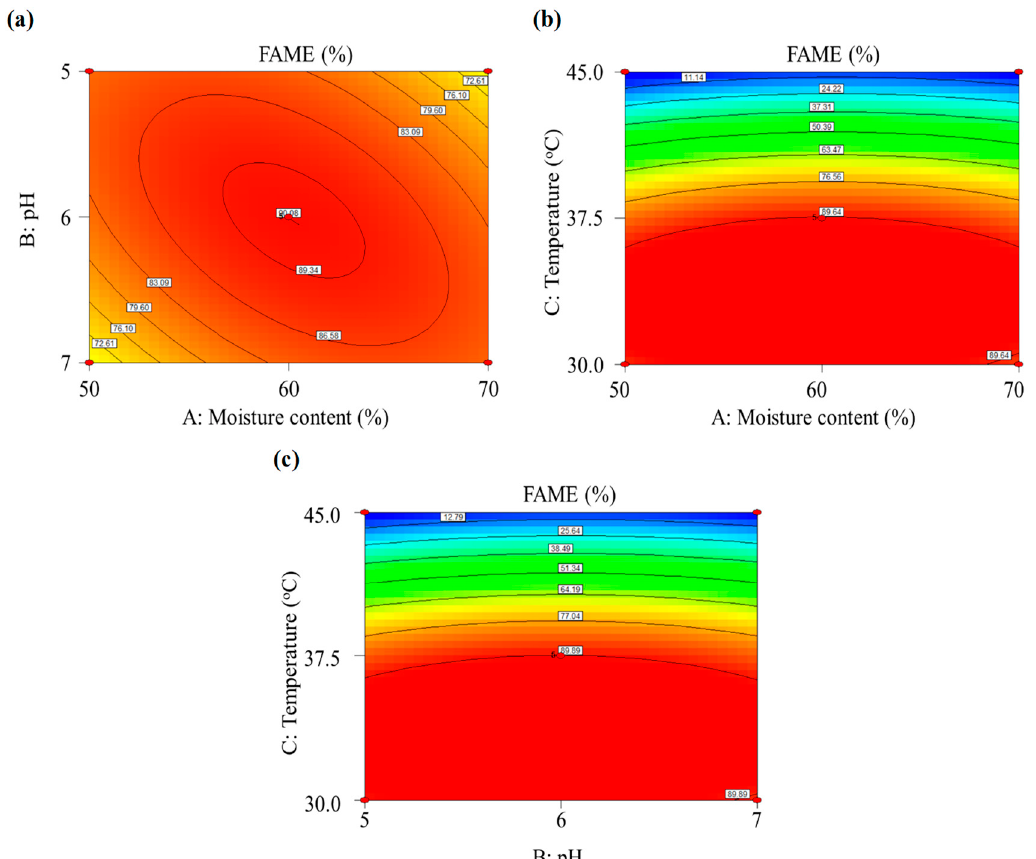
Figure 2. Two-dimensional contour plots showing the effect of ( A ): moisture content (%), ( B ): pH, ( C ): temperature (°C) on fatty acid methyl esters (FAME; %) synthesized by esterification. One variable kept constant at its center point and other two variables varied within the experimental range. As shown in ( a – c ).